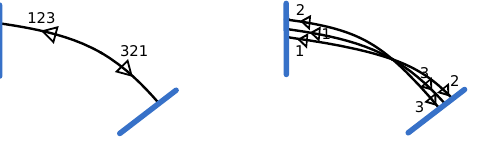
Figure 32 . Left: two triangles in the triangulation of C . One triangle T and one edge E are marked. The edge E is decorated by an auxiliary choice of orientation. Right: the corresponding cycles γ , γ 1 , γ 2 on e C . T E E